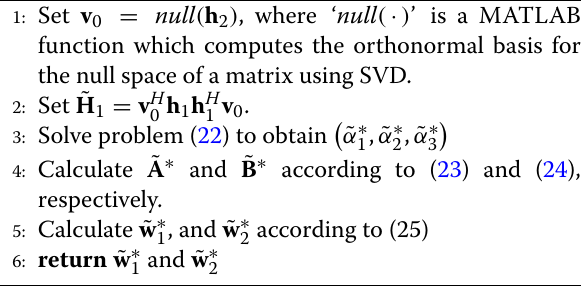
Algorithm 2 The SVD-based suboptimal solution to problem